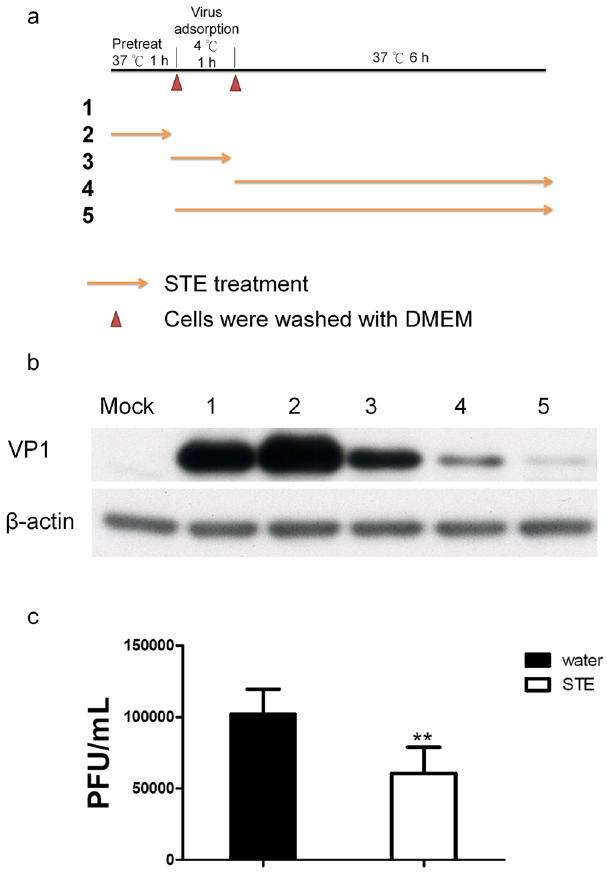
Figure 2. STE inhibits EV71 infection during adsorption and post-adsorption phases. ( a ) The time-of-addition experiment was performed to determine the stage of infection, at which STE exerts its antiviral activity. RD cells were mock-infected. RD cells were incubated with BrCr at m. o. i. of 20 at 4 °C, washed free of virus, and cultured for 6 h prior to analysis for VP1 expression (condition 1; positive control). Cells were pre-treated with 1250 µ g/ml STE for 1 h, incubated with virus, washed, and cultured for 6 h before analysis (condition 2). Cells were incubated with virus in the presence of 1250 µ g/ml STE for 1 h, washed, and cultured for 6 h before analysis (condition 3). Cells were incubated with virus, washed, and treated with STE for 6 h before analysis (condition 4). Cells were incubated with virus in the presence of 1250 µ g/ml STE for 1 h, washed, and treated with STE for 6 h before analysis (condition 5). ( b ) Expression of VP1 and β -actin in cells treated under aforementioned conditions was determined by western blotting. The cropped images of the blots are shown. A representative experiment out of three is shown. ( c ) Interaction of virions with STE reduces the viral infectivity. The viral preparation was incubated with 1250 µ g/ml STE or water at 4 °C for 1 h. The reaction mix was filtered through Amicon filter, and the retentate was assayed for viral titer. Data are means ± SD of three separate experiments. ** P < 0.01, vs. water treatment